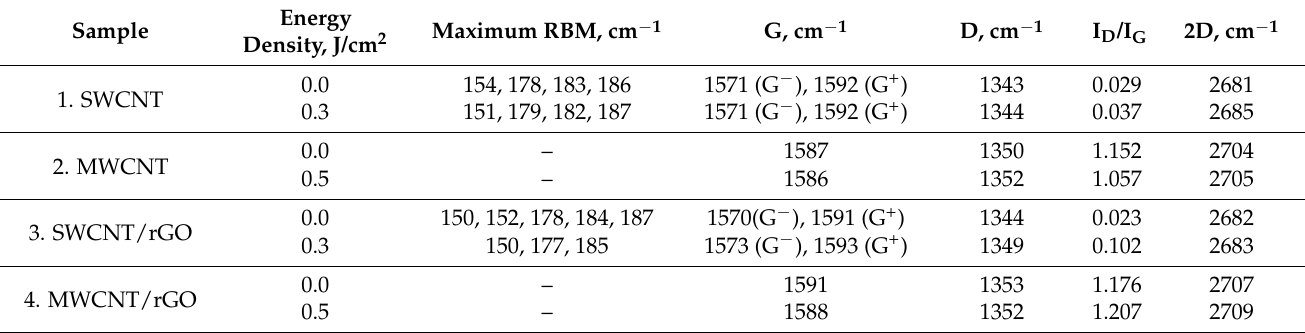
Table 2. Characteristic bands of Raman spectra.